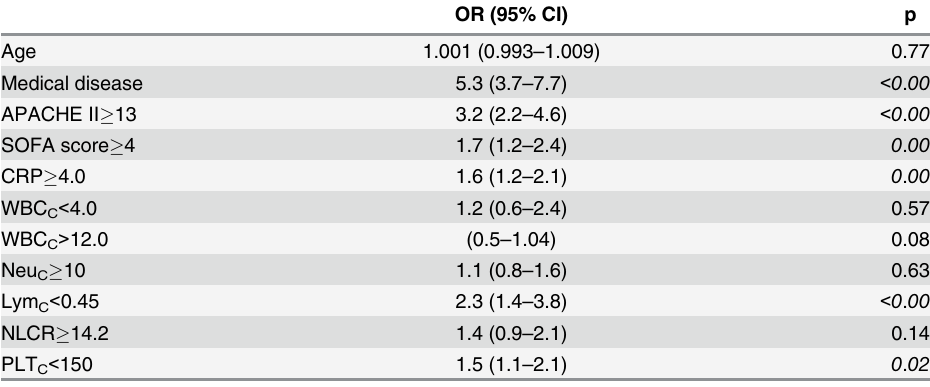
Table 2. Multivariate logistic regression model for